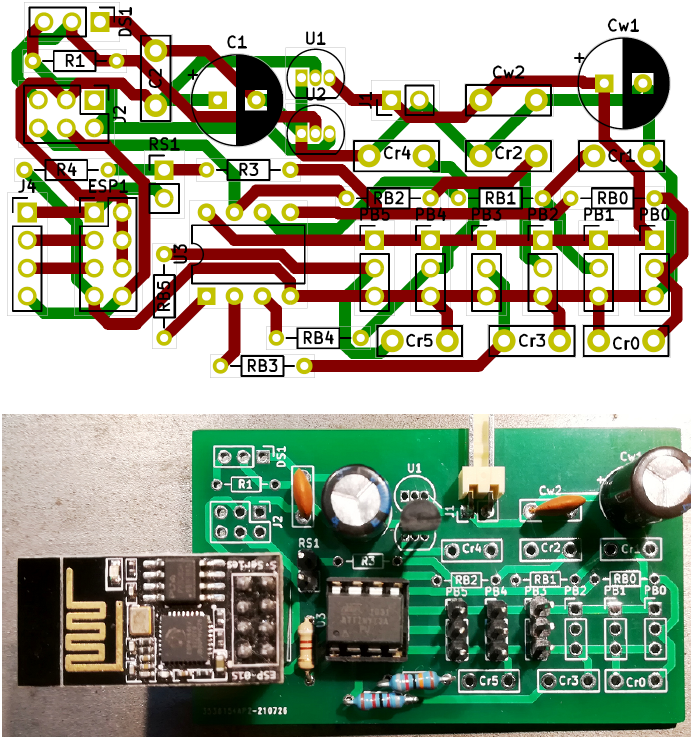
Figure 5. PCB design for a universal measurement system which we have developed ( top figure) for our research and its practical implementation according to our design template ( bottom